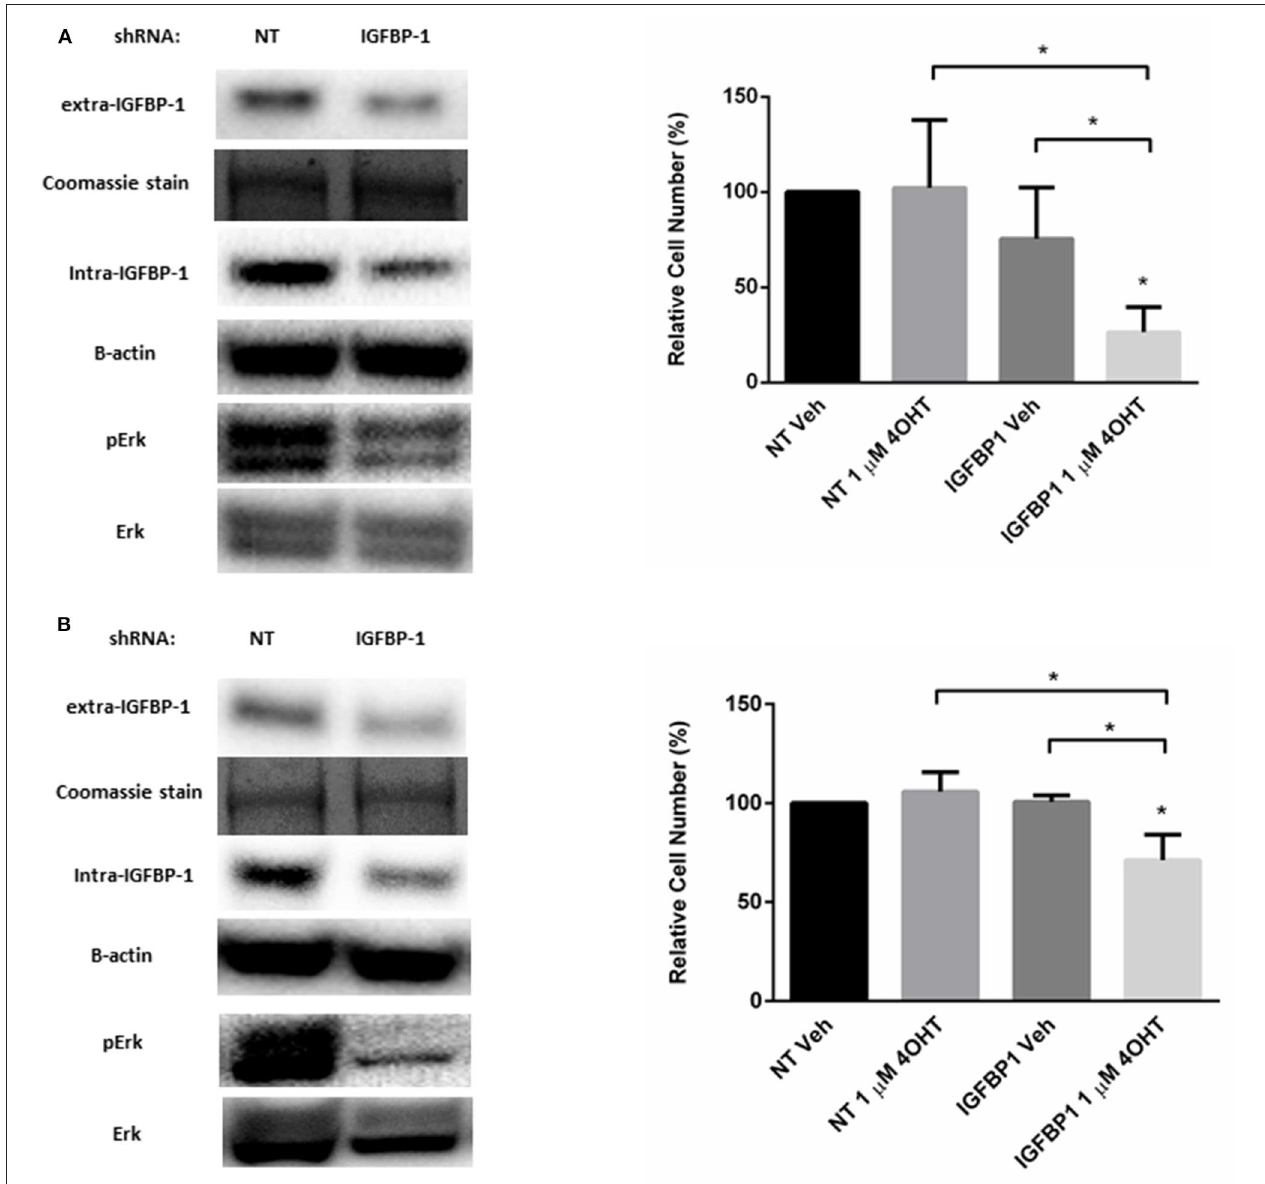
FIGURE 6 | Knockdown of IGFBP-1 in MCF7-BP1 and T47D-BP1 reduced the level of phospho-Erk and sensitized the cells to 4-OHT. (A) Immunoblot analysis of IGFBP-1, phospho-Erk, and Erk after transfected with non-targeting (NT) shRNA or IGFBP-1 shRNA in MCF7-BP1 (left); measurement of relative cell number (%) in MCF7-BP1 after transfected with NT shRNA or IGFBP-1 shRNA and treated with either vehicle or 1 µ M 4-OHT (right). (B) Immunoblot analysis of IGFBP-1, phospho-Erk, and Erk after transfected with non-targeting (NT) shRNA or shRNA for IGFBP-1 in T47D-BP1 (left); measurement of relative cell number (%) in T47D-BP1 after transfected with NT shRNA or IGFBP-1 shRNA and treated with either vehicle or 1 µ M 4-OHT (right). Results are the average of 3 independent experiments, and error bars are the standard error of the mean. * p <